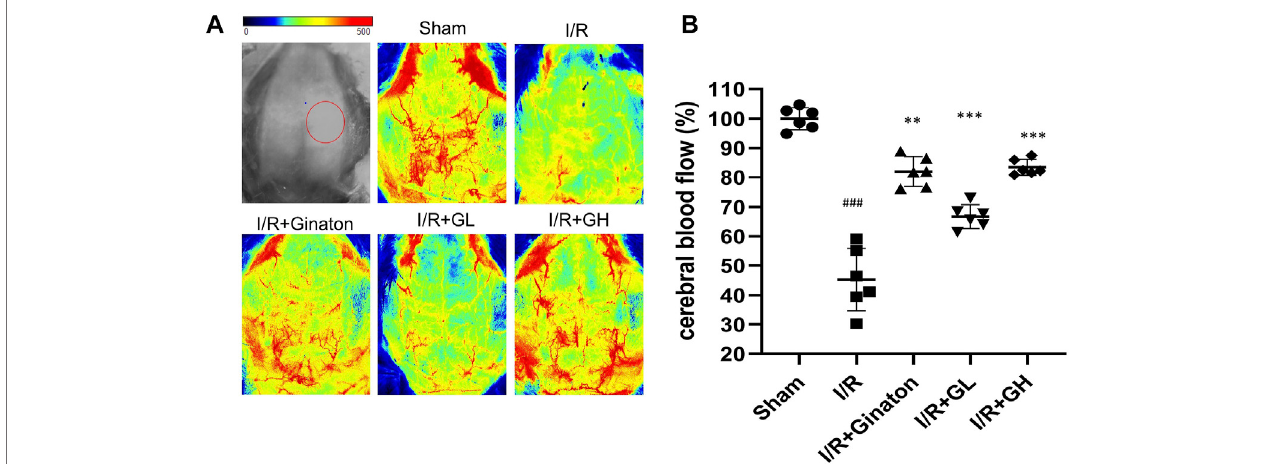
FIGURE 2 | Administration of GHI for 6 consecutive days enhanced rCBF in MCAO-induced rats; (A) the representative rCBF images of rats with various treatments; (B) quantitative results of rCBF ( n = 6); ### p < 0.001 compared with sham, ** p < 0.01, *** p < 0.001 compared with the I/R group. RNA-seq analysis of GHI- mediated cerebral protection.